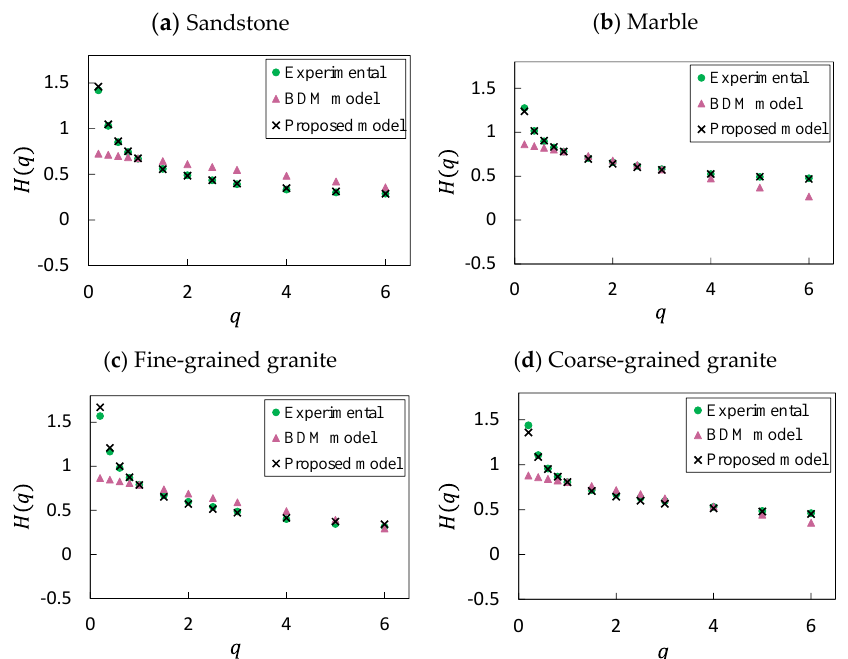
Figure 5. Experimental and predicted multiscaling spectra of the rock fractured surfaces: sandstone (a), marble (b) fine-grained granite (c), and coarse grained granite (d). Predicted spectra by the proposed model are very close to experimental ones.